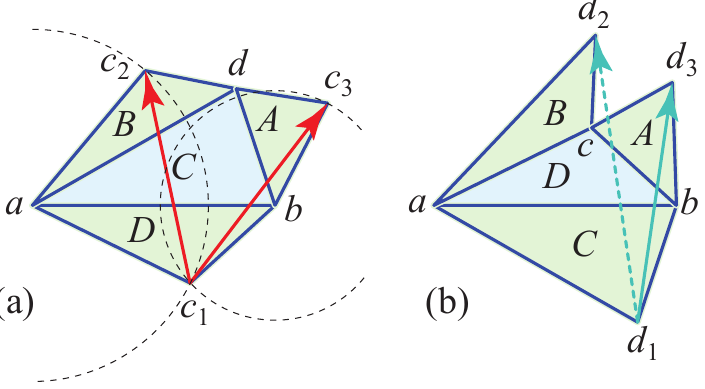
Figure 7. Case 2.2.3: c is closer than d to both a and b . Q c , Q (cid:48) c red ( a ), Q d , Q (cid:48) a , b , c , d are 284 ◦ ,200 ◦ ,58 ◦ ,178 ◦ .